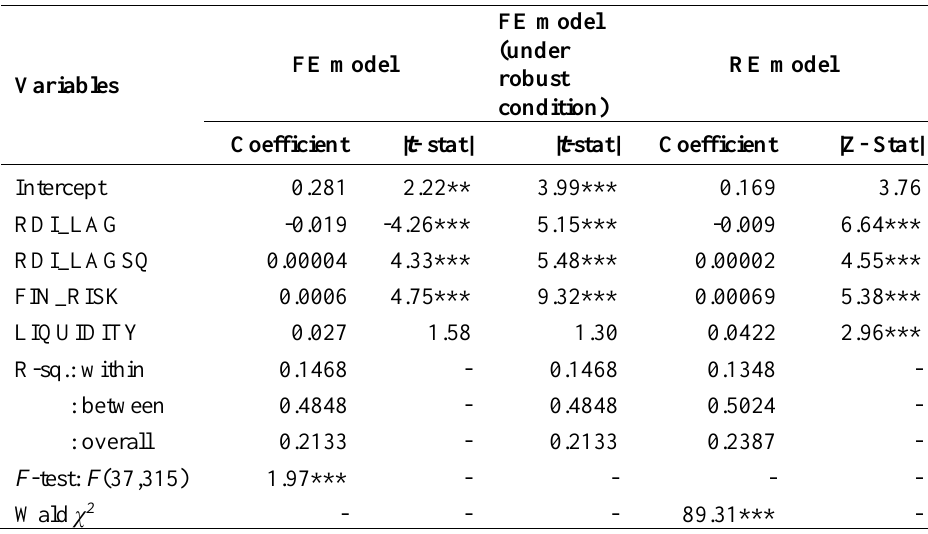
Table 4: Factors Affecting ROE